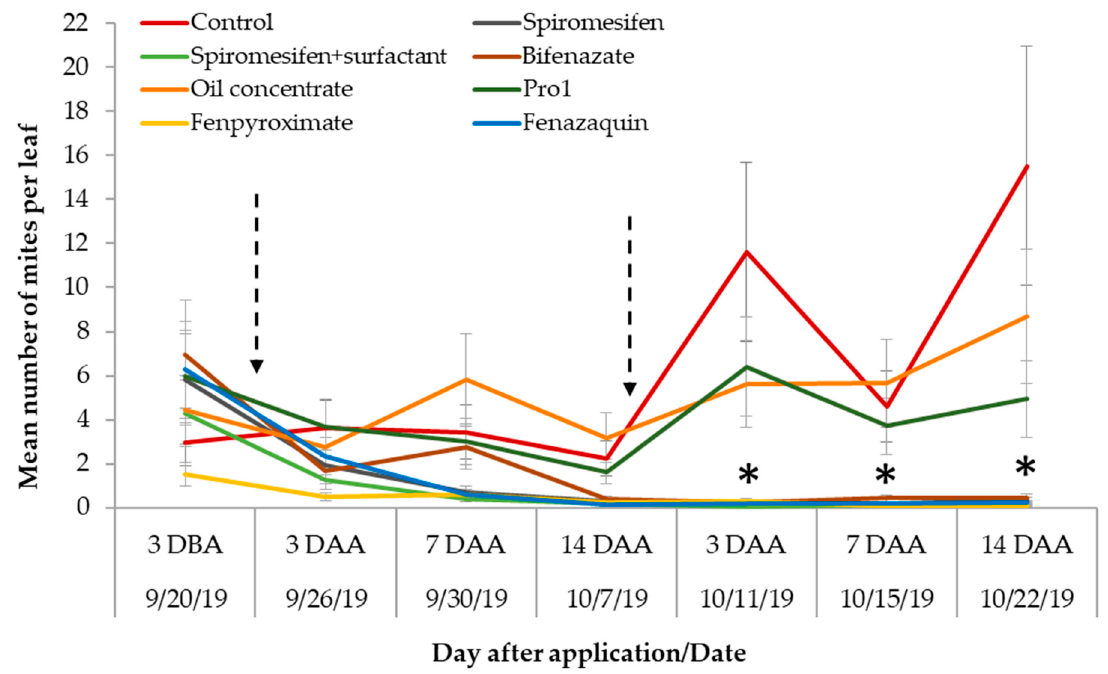
Figure 2. Mean (± SE) number of southern red mites per leaf recorded three days before miticide application (DBA), three, seven, and fourteen days after miticide application (DAA). Two miticide applications were conducted 15 days apart (on 9/23/19 and 10/8/19) represented here by the dotted arrows. Asterisks represent significant differences for mite numbers per leaf recorded on five treatments over time (Treatment*Sampling event interaction, F 42, 837 = 6.47; p < 0.0001) compared with control, oil concentrate and Pro1 treatments.